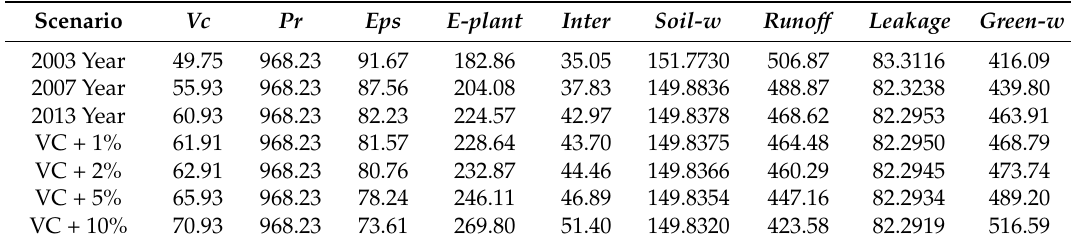
Table 8. Impact of vegetation coverage increase on